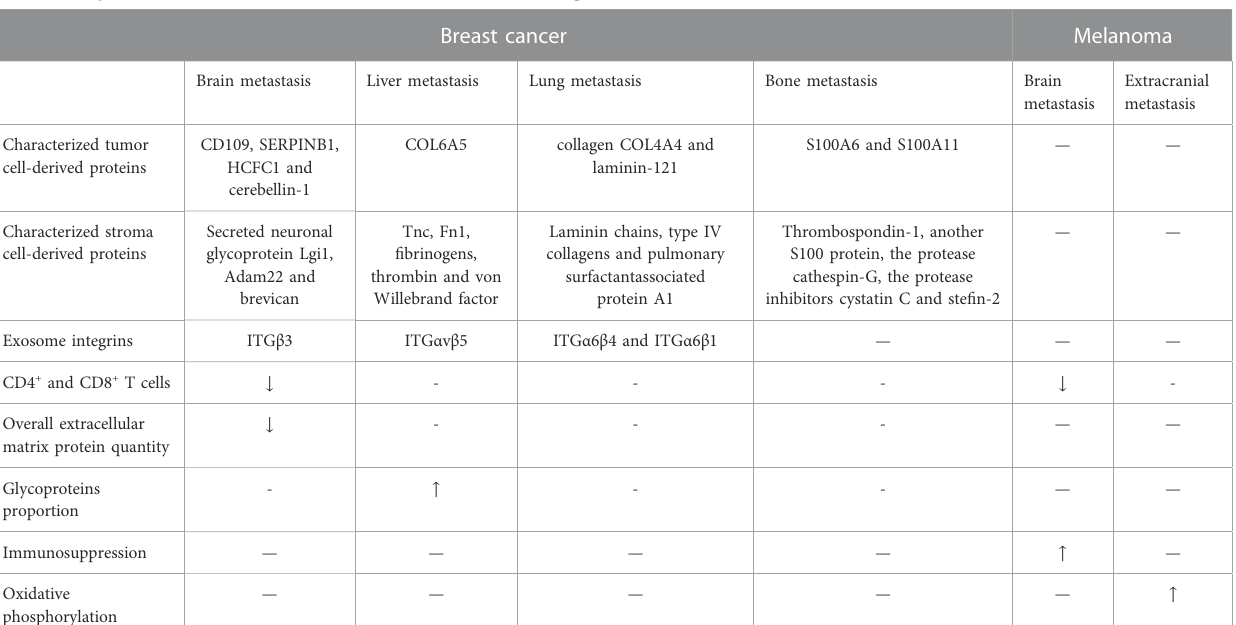
TABLE 4 Comparison between BrMs and extracranial metastasis. ITG,